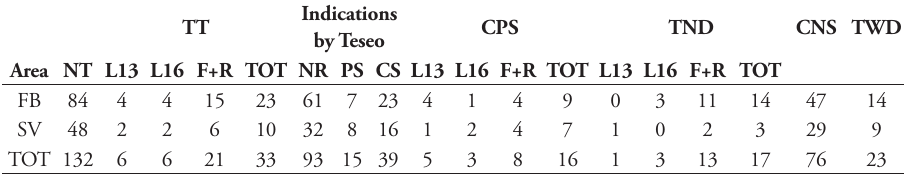
Table 5. Accuracy measurements in Forcella Buana (FB) and San Vito (SV) considering larvae and frass and remains of adults (F+R) as target. NT: total number of trees investigated; TT: total number of targets present in trees; L13 and L16: total number of trees colonised by larvae of O. eremita in 2013 and 2016 respectively; F+R: total number of trees in which frass (F) and/or remains of adults (R) were found in 2013 and 2016; NR: no reaction; PS: partial signalling; CS: complete signalling; CPS: correct